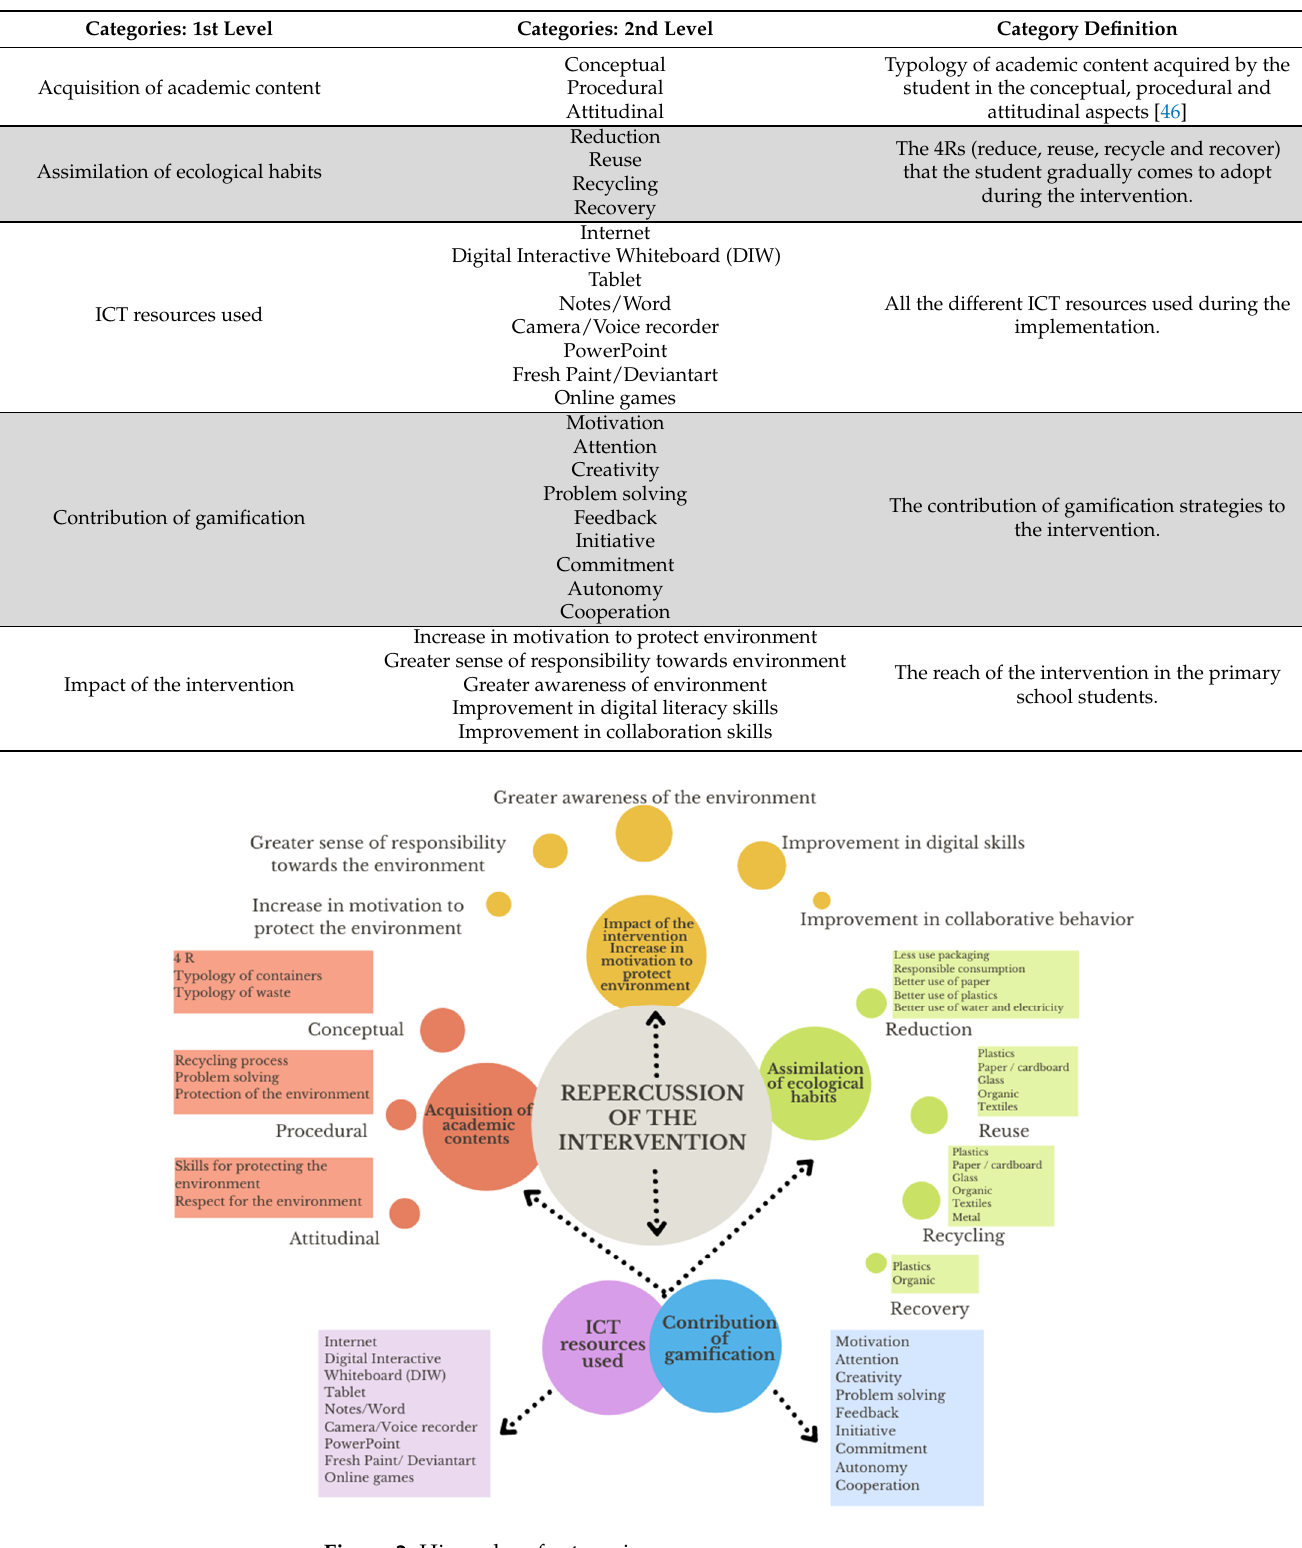
Figure 2. Hierarchy of categories.